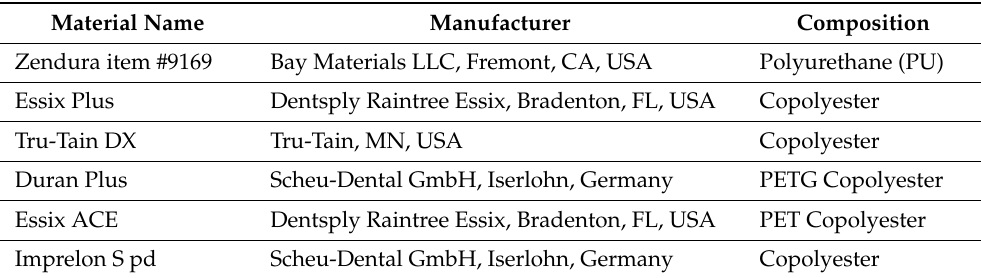
Table 1. Thermoplastic retainer materials analyzed in this study (their compositions were obtained from their material safety data sheets (MSDSs)).